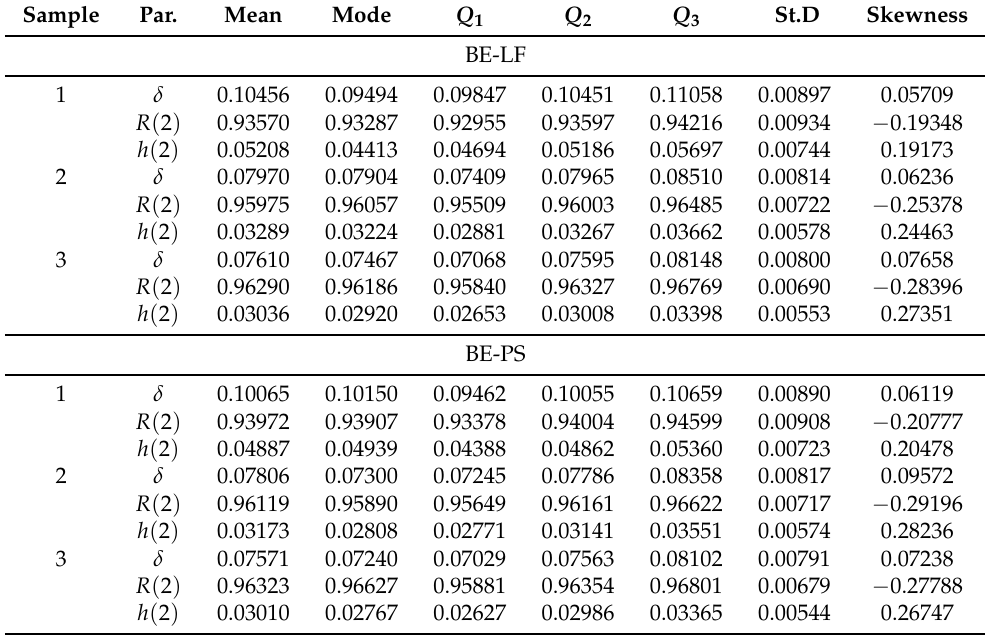
Table 5. Some properties of MCMC draws of δ , R ( t ) and h ( t ) from mechanical equipment